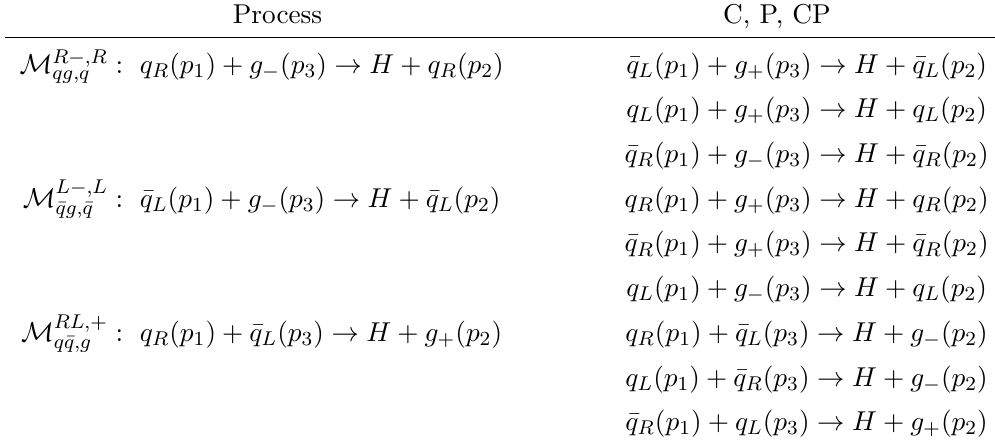
Table 3. Different kinematic crossings of the H → q ¯ qg amplitudes. The comma is used to separate the helicities of initial and final state